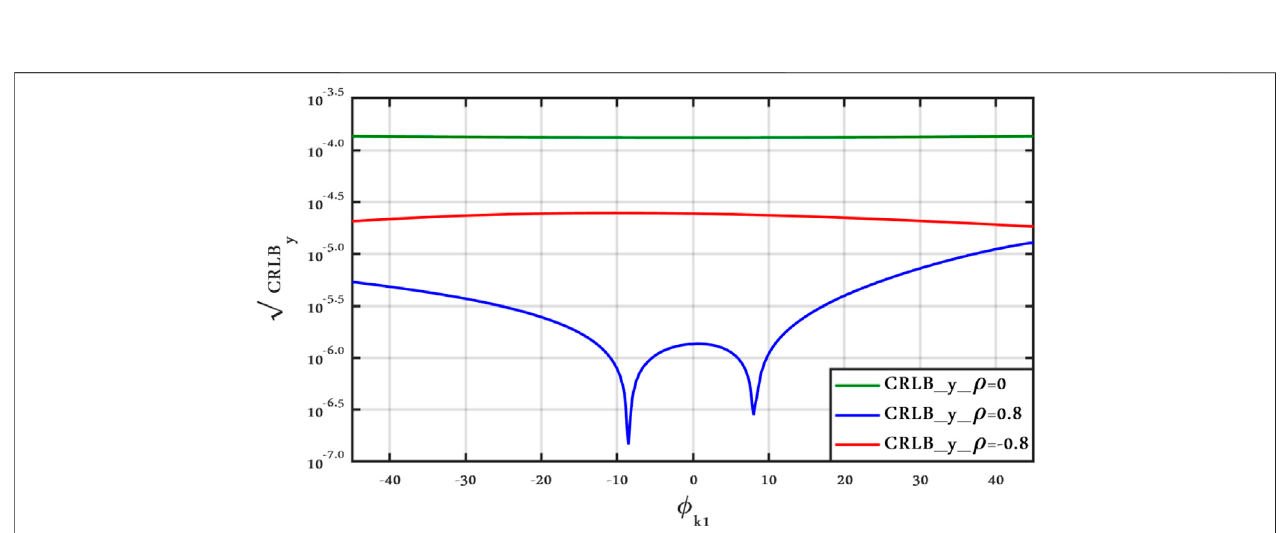
FIGURE 11 | CRLB x vs. ϕ k 1 antenna position, Clutter Model II for different ρ with ] = 2.1, SCR = 0 dB , and v x = v y = 50 m/s.